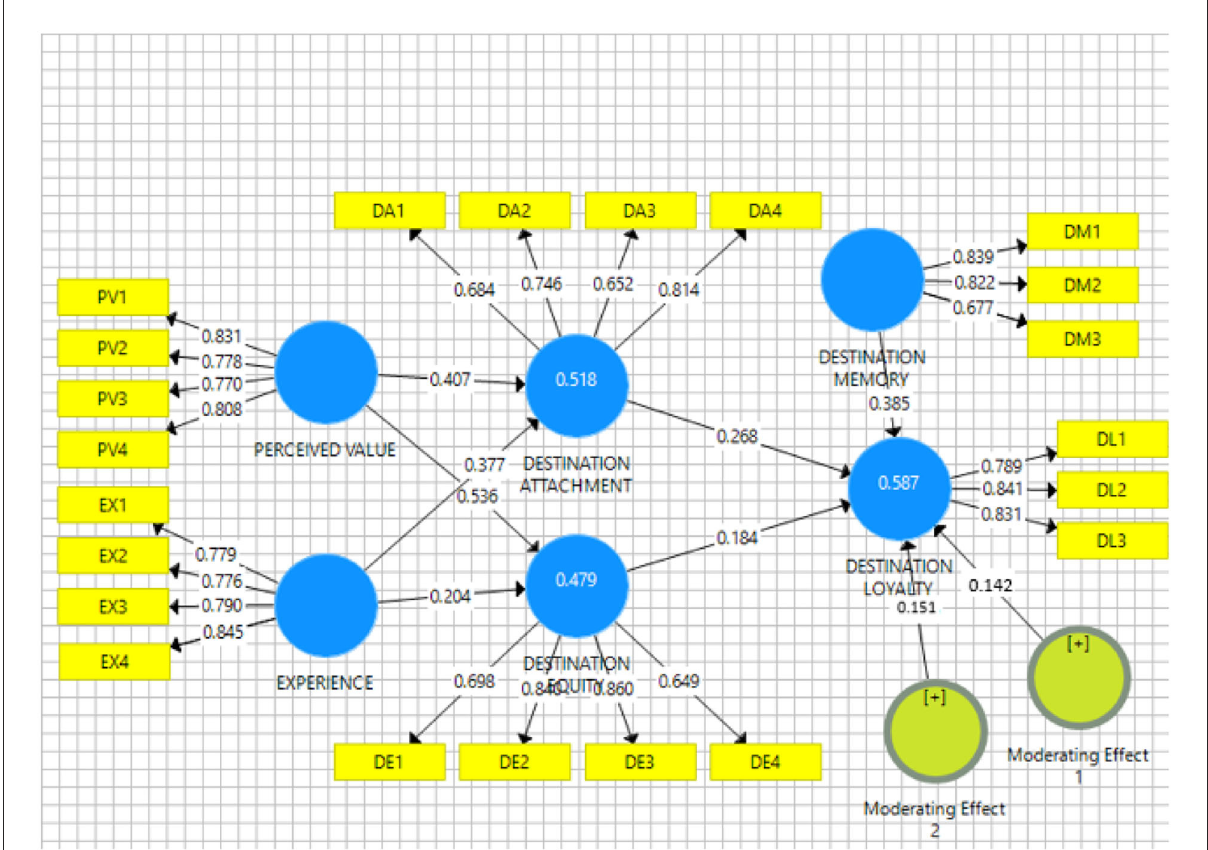
FIGURE2 The path coefficients of the structural model are